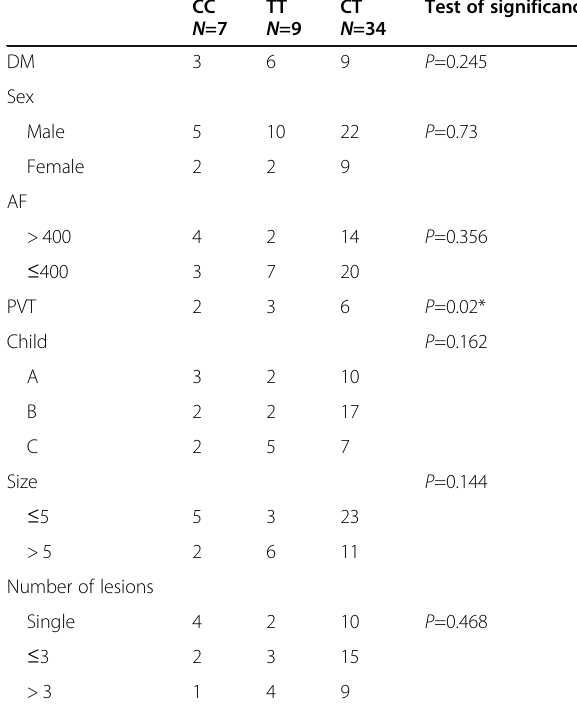
Table 8 Association between genotype and demographic